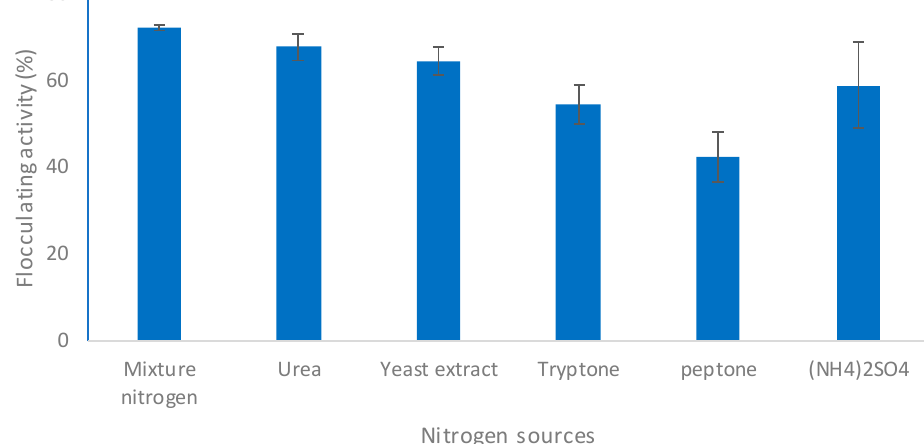
Figure 6. Effect of nitrogen source on bioflocculant production.